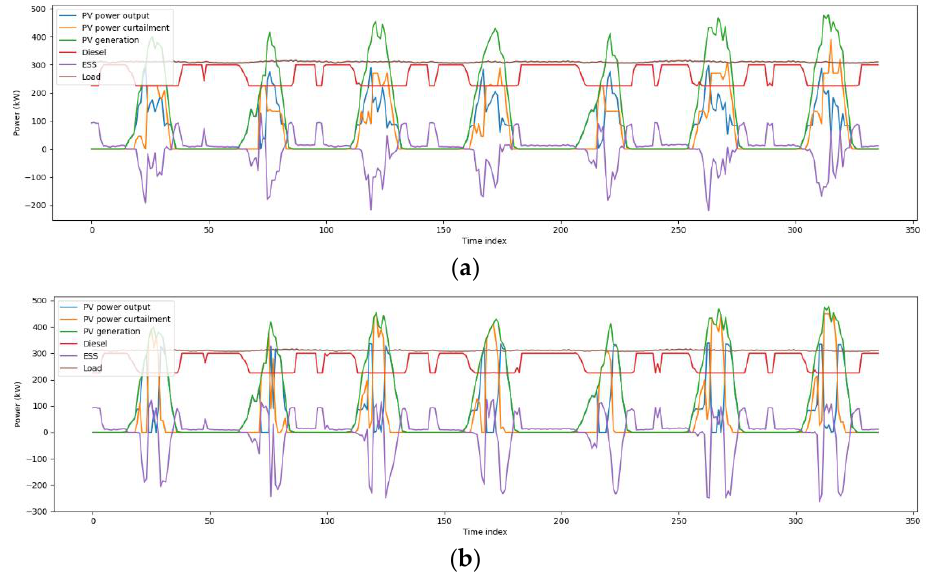
Figure 7. Simulation results of proposed method ( a ) and conventional method ( b ) for 7 days of March.